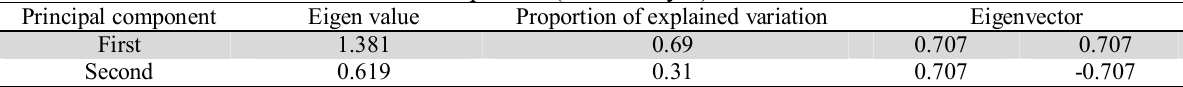
Normalized Normalized SNR SS SNR SS